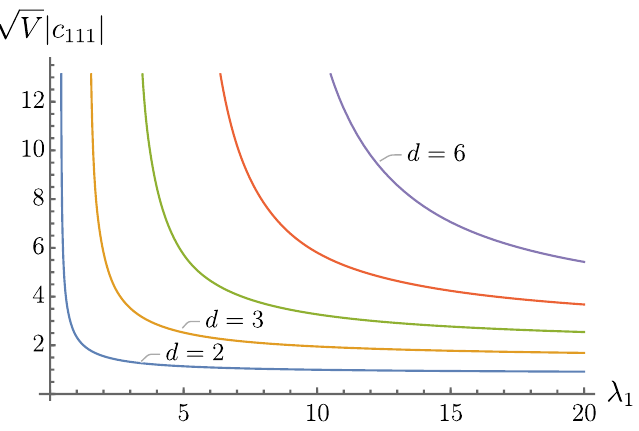
Figure 7 . Upper bounds on the triple overlap integrals of the lightest nontrivial scalar eigenfunctions on closed hyperbolic manifolds of dimension d ∈ { 2 , 3 , 4 , 5 , 6 }